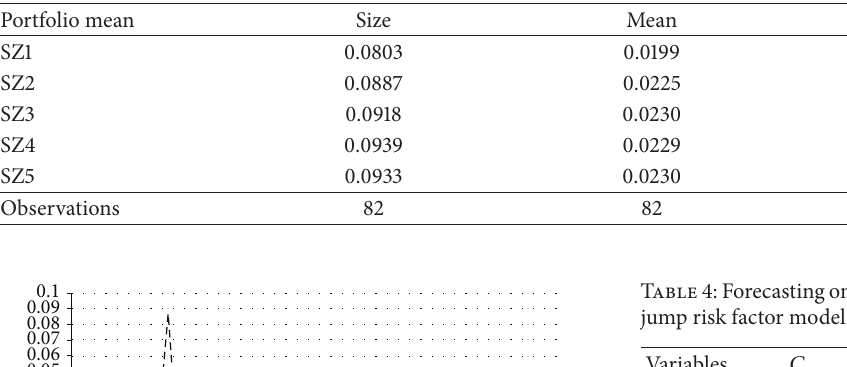
Table 3: Descriptive statistics of jump components for portfolios.